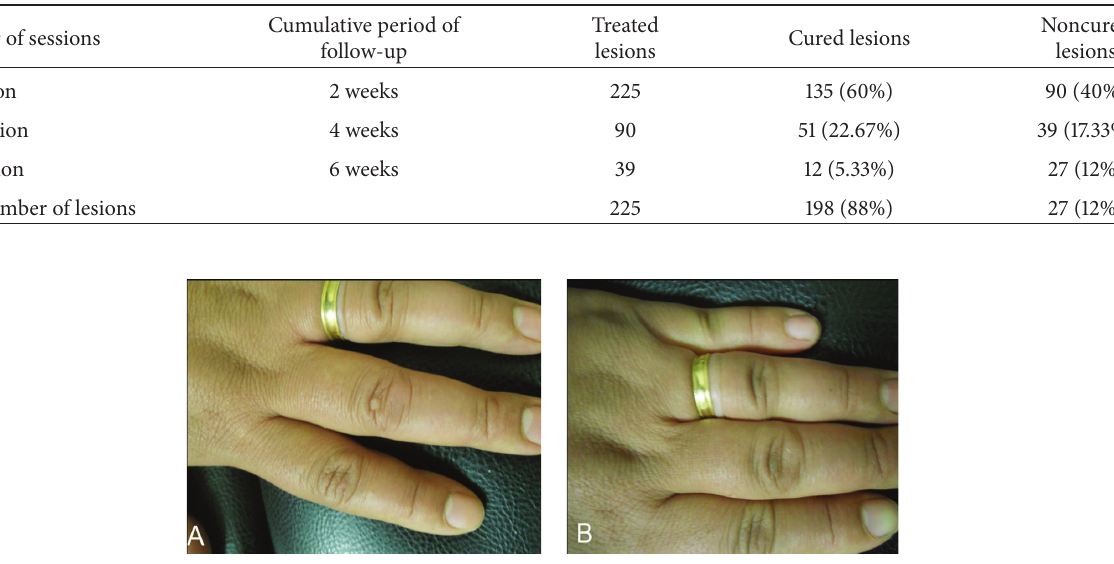
Table 1: The clinical effectiveness of intralesional injection of 2% zinc sulfate solution in the treatment of common warts.